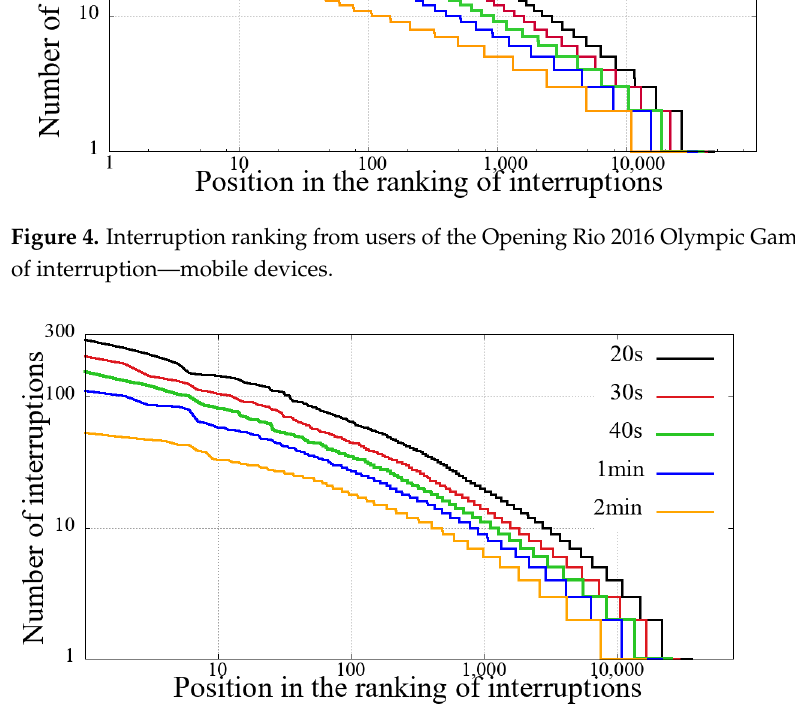
Figure 5. Interruption ranking from users of the Opening Rio 2016 Olympic Games for different sizes of interruption—non-mobile